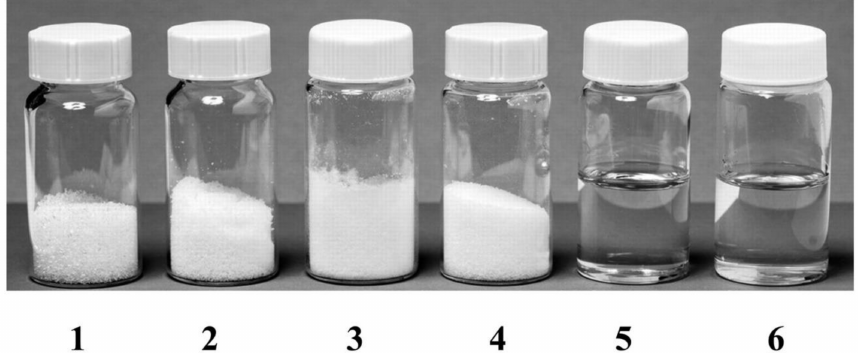
Figure 1. Some examples of natural eutectic solvents (NADESs) and NADESs components. Vial 1, sucrose; vial 2, fructose; vial 3, glucose; vial 4, malic acid; vial 5, sucrose:fructose:glucose (1:1:1, molar ratio); vial 6, sucrose:malic acid (1:1, molar ratio. Reprinted from Choi, Y.H.; van Spronsen, J.; Dai, Y.; Verberne, M.; Hollmann, F.; Arends, I.W.C.E.; Witkamp, G.J.; Verpoorte, R. Are Natural Deep Eutectic Solvents the Missing Link in Understanding Cellular Metabolism and Physiology? Plant Physiol., 2011, 156 (4), 1701–1705 with permission from Oxford University Press